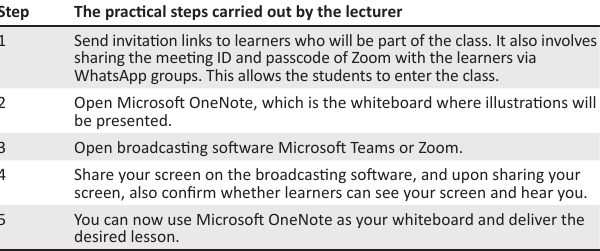
TABLE 3: Example of the practical processes involved with the use of Microsoft OneNote.